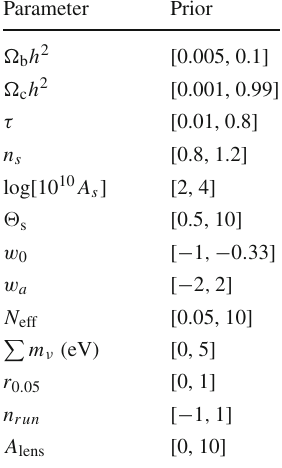
Table 1 Flat priors on the main cosmological parameters constrained in this paper